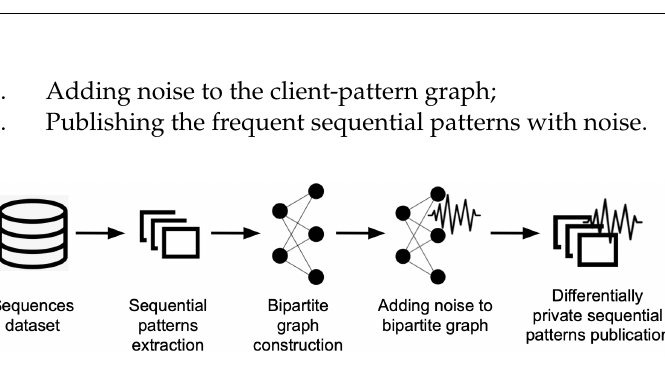
Figure 1. Process of sequential patterns’ sanitization through our graph-based differentially pri- vate